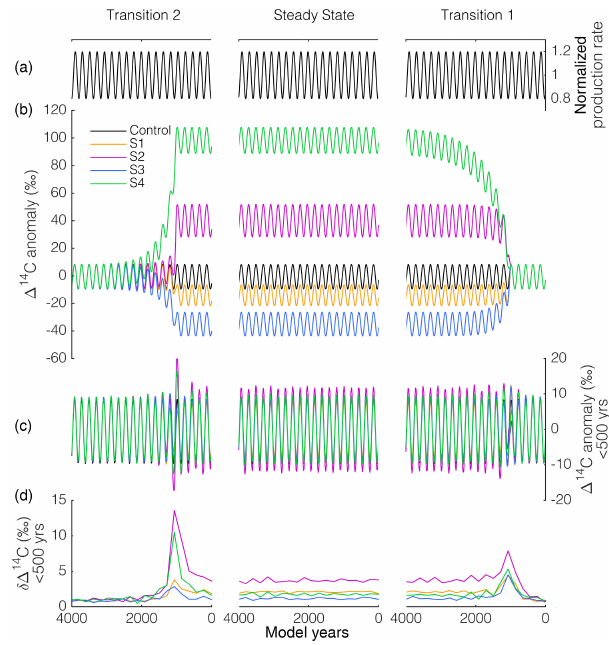
Figure 4. Carbon cycle sensitivity experiments. (a) Normalized 14 C production rate input to the model. (b) Modelled (cid:49) 14 C anomaly. (c) centennial (<500 year) anomalies of modelled (cid:49) 14 C shown in (b) . (d) differences in the centennial (cid:49) 14 C variations (c) from the control run. All model runs and panels are shown for the transition from preindustrial to perturbed conditions (transition 1, right), steady state of the perturbed conditions (steady state, mid- dle), and the transition back to preindustrial carbon cycle conditions (transition 2, left). See also Sect.